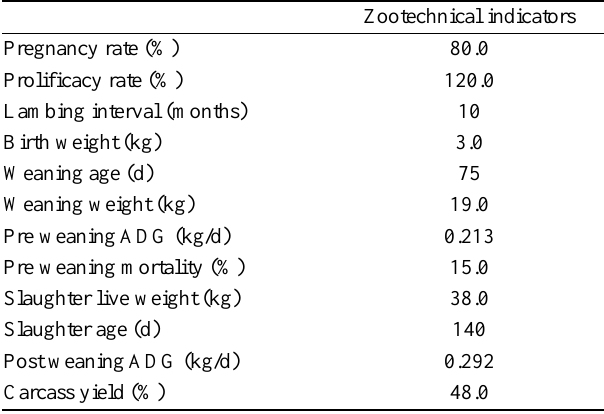
Table 1. Zootechnical indicators of the representative property studied, according to data obtained in panel meeting